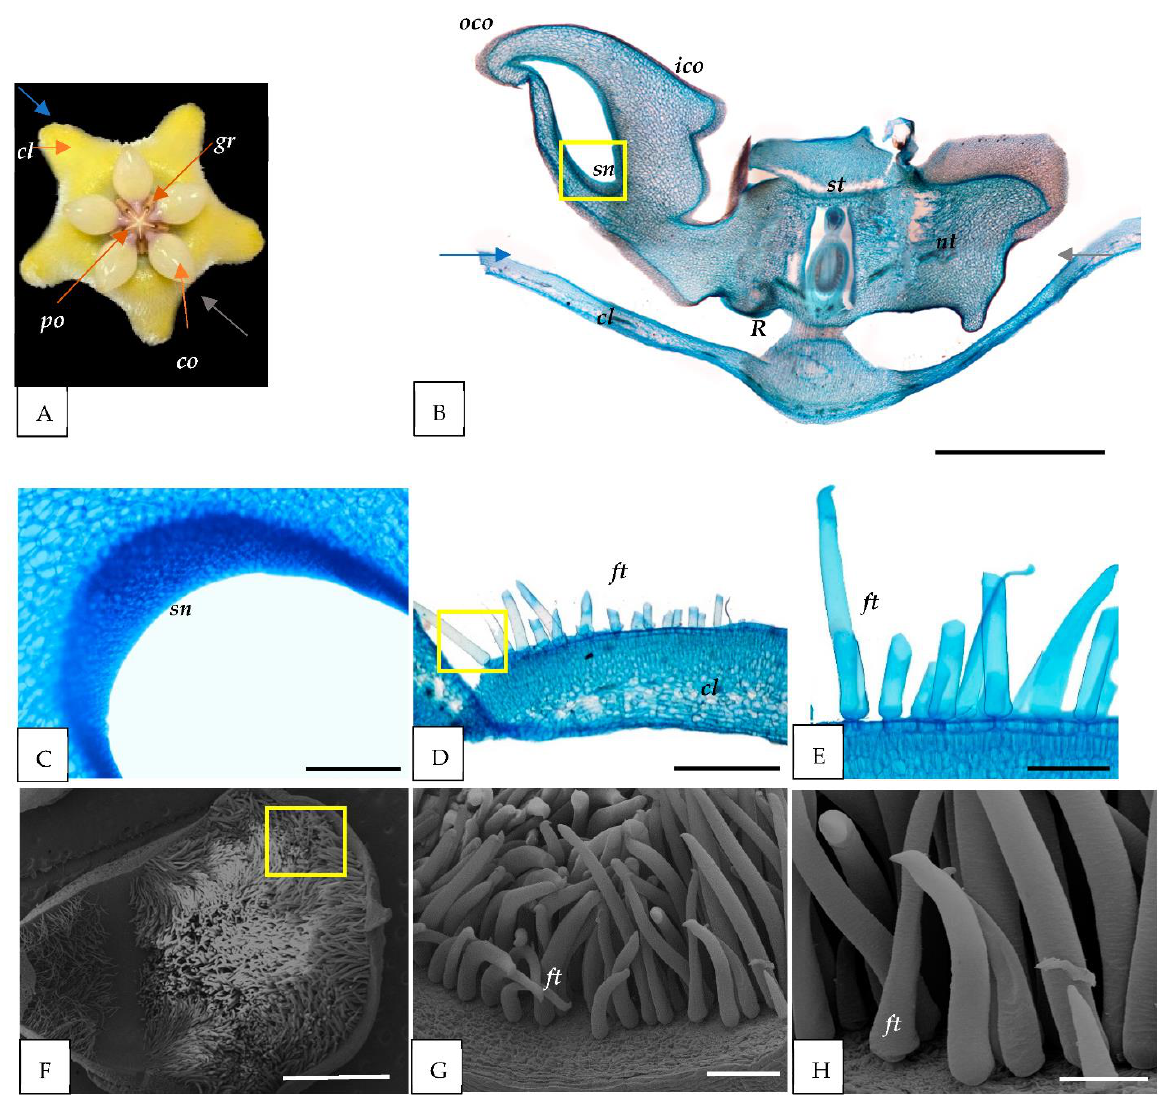
Figure 3. Anatomical and micromorphological structure of the H. coriacea flower parts. ( A ) Flower of H. coriacea (front view) with five corolla petals ( cl ), five corona lobes ( co ) with inner ( ico ) and outer ( oco ), five pollinia ( po ), and five guide rail ( gr ) between each corona lobe. ( B – E ) LM images. ( B ) Longitudinal section of the flower cut in a plane indicated by gray and blue arrows in ( A ); ( C ) secondary nectaries ( sn ) cells observed in the corona lobe ( co ); and ( D , E ) cross-sections of corolla petals with unicellular falcate trichomes ( ft ) (yellow square) on the abaxial surface. ( F – H ) SEM image of the petals ( cl ); ( G , H ) enlargement in ( F ) (yellow square) show the presence of ft . cl = corolla; co = corona; gr = guide rail; sn = secondary nectaries; R = nectar pool; nt = nectar tube; st = style head. Scale: ( B ) = 2000 µm; ( C ) = 1000 µm; ( D ) = 500 µm; ( E , H ) = 200 µm; ( F ) = 1 mm; and ( G ) = 100 µm.